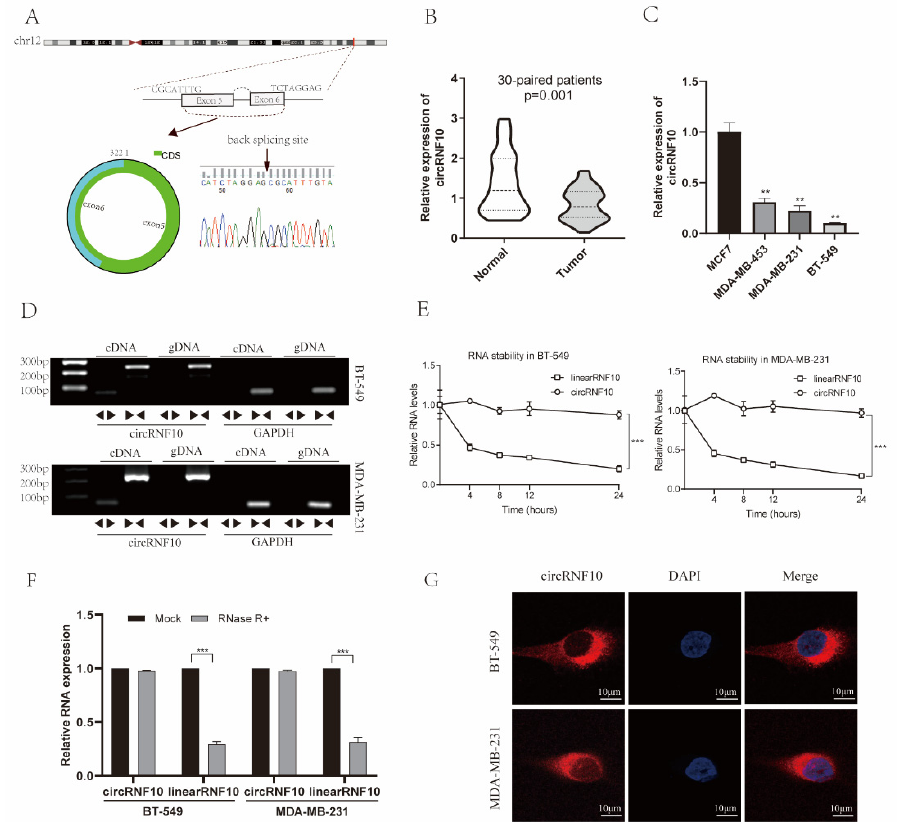
Figure 2. Characterization of circRNF10. ( A ) Schematic illustration of circRNF10 originating from exons five and six of RNF10 and Sanger sequencing of circRNF10 indicate a back-splice junction. ( B ) Violin plots for circRNF10 expression in BC by qRT-PCR. ( C ) Expression levels of circRNF10 in BC cells (MCF7, MDA-MB-453, MDA-MB-231, BT-549). Experiments were repeated thrice. ** p < 0.01. ( D ) Existence of circRNF10 was confirmed in BC cells by RT-PCR. Divergent primers were performed to amplify circRNF10 in cDNA rather than gDNA. ( E ) Relative RNA levels of circRNF10 and RNF10 mRNA under treatment with actinomycin D in BC cells. The experiments were repeated three times. *** p < 0.001. ( F ) mRNA expression of circRNF10 and RNF10 in RNase R-treated BC cells was analyzed by qRT-PCR. Experiments were repeated thrice. *** p < 0.001. ( G ) Subcellular localization of circRNF10 was determined by FISH. Scale bar, 10 µ